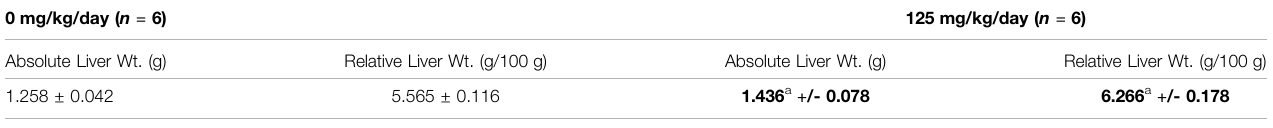
Means ± standard deviations are shown. a Statistically different from control mean by Student ’ s T-test, Alpha (cid:1) 0.05. Bold values were considered treatment-related effects.